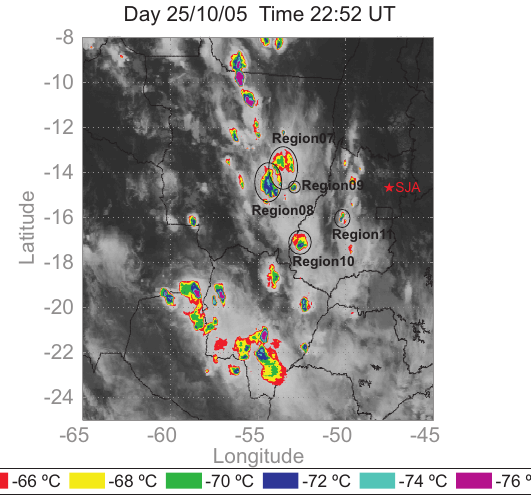
Fig. 2. Grayscale GOES 12 IR image of Brazil’s Central-West, part of Southeast regions and neighboring countries (Bolivia, Paraguay and Argentina) of the night of 30 September–1 October 2005. It shows the locations of the cloud top regions with T < − 66 ◦ C color enhanced in 2 ◦ C intervals. The 6 selected convective regions are indicated with circles.